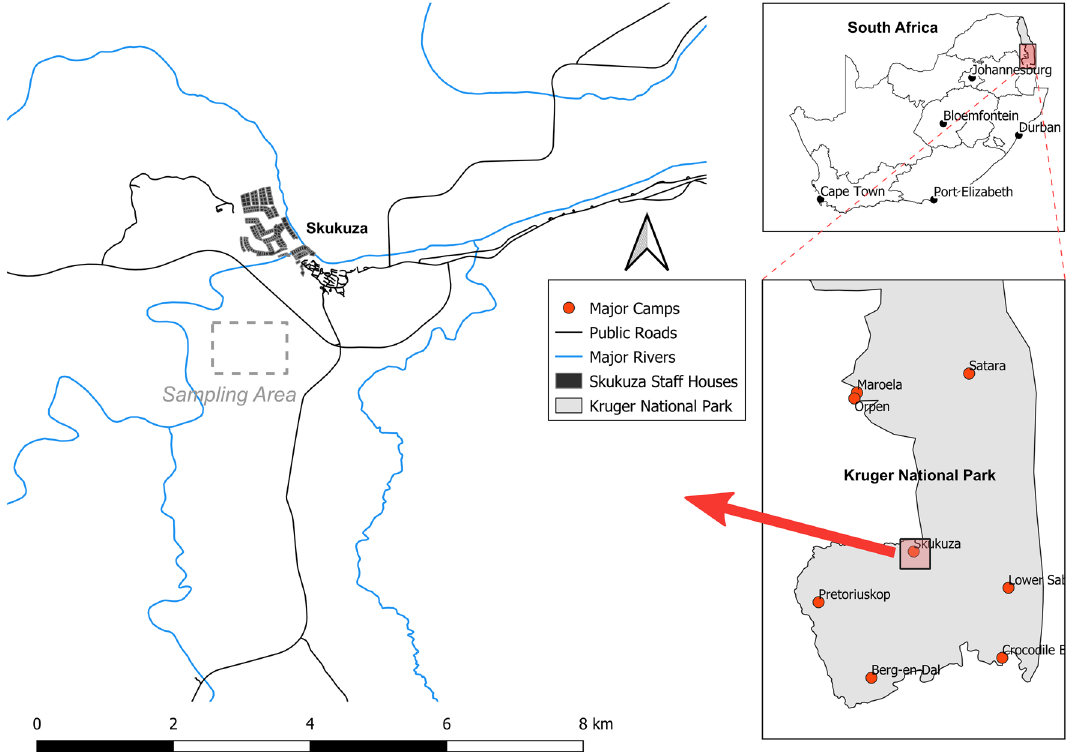
Figure 5. The study site is situated approximately 1 km south-west of the Skukuza Rest Camp in the south of Kruger National Park, South Africa.